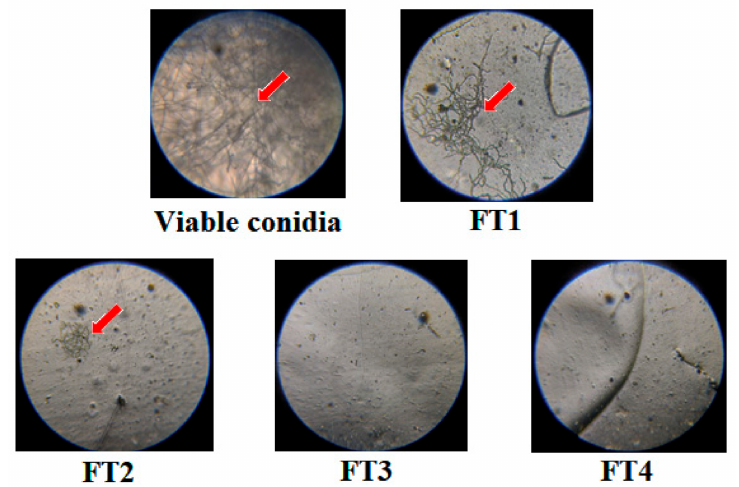
Figure 10. Germination of viable conidia from Clonostachys rosea on the surface of the films FT1–FT4. The control of germination was performed on PDA (viable conidia). Red arrows indicate the prolifer- ation of